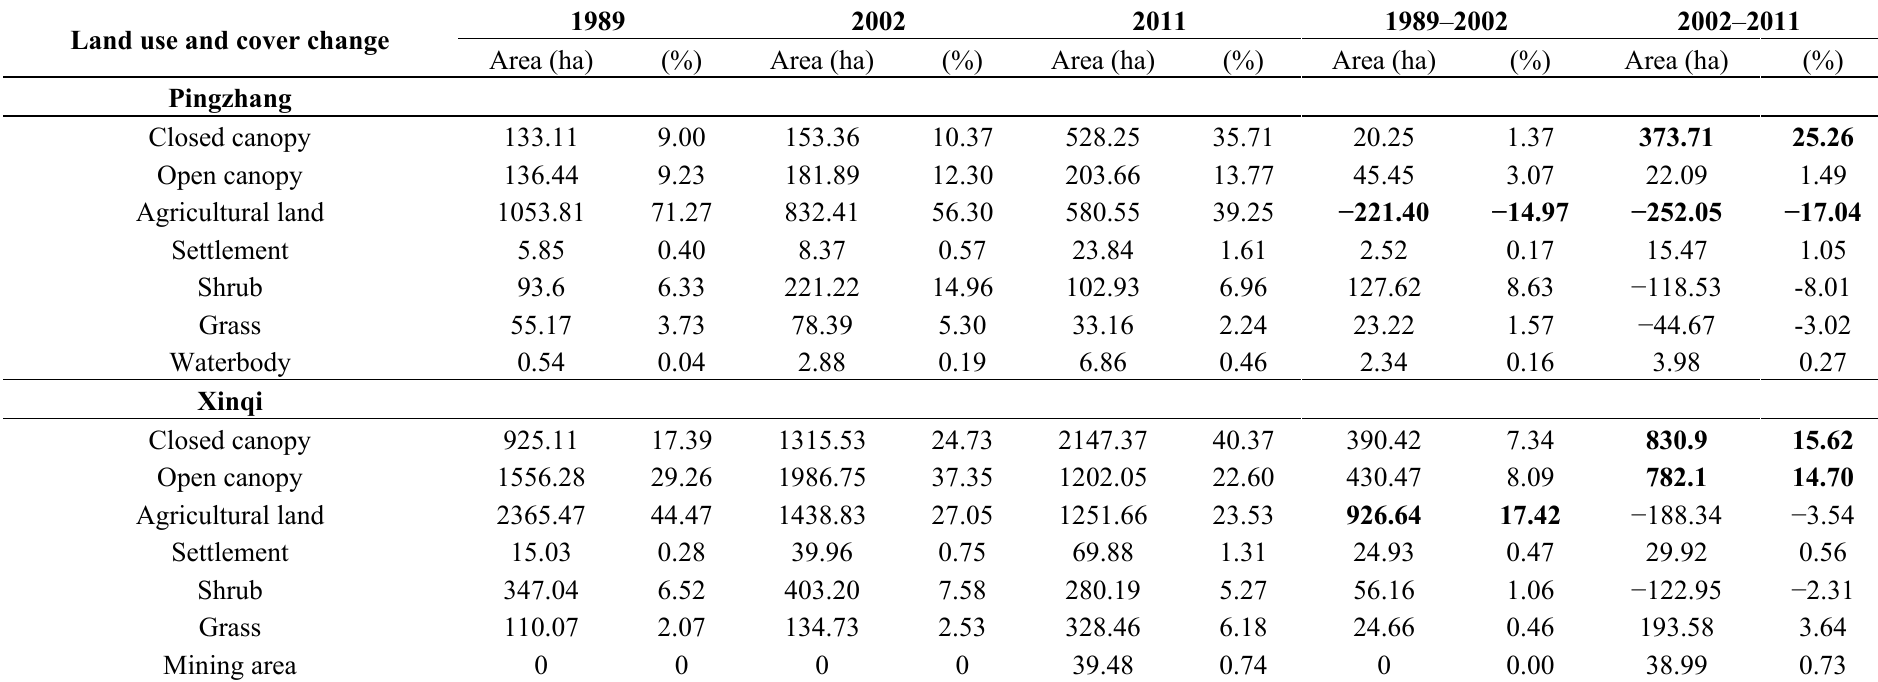
Table 4. Land use and cover change in Pingzhang and Xinqi in 1989, 2002 and